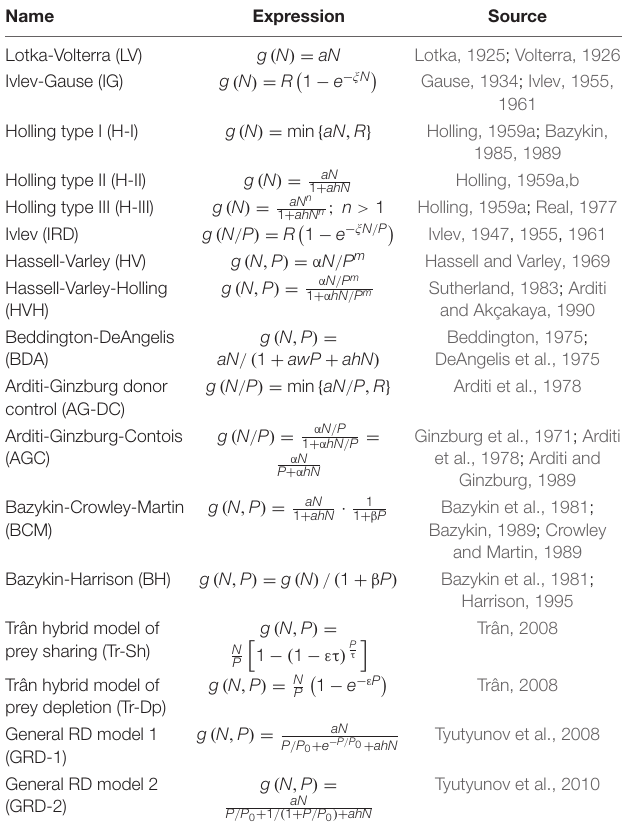
TABLE 1 | Examples of trophic functions without and with mutual interference of